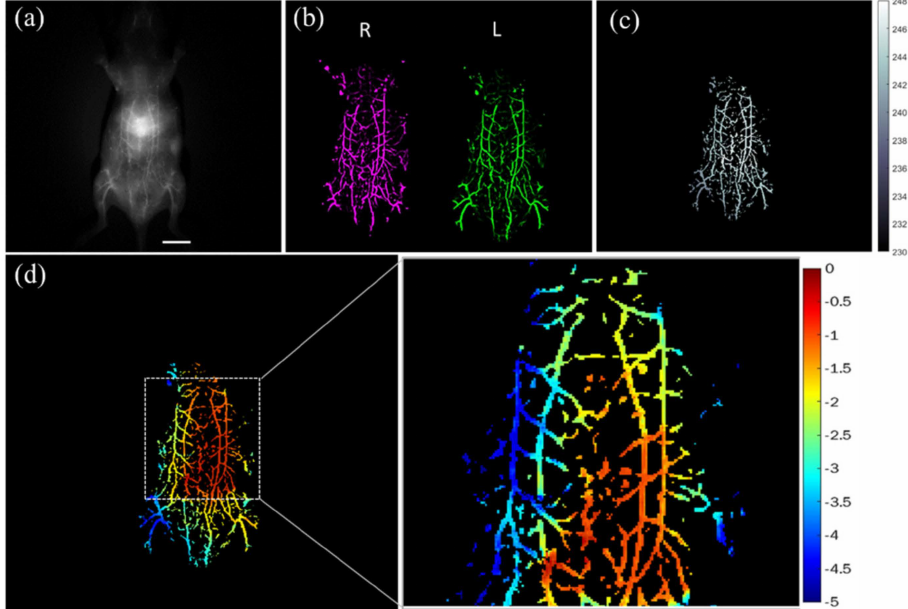
Figure 6. Results of in vivo 3D blood vessel study: ( a ) 2D NIR-II image (scale bar, 10 mm), ( b ) left and right vessel enhanced images, ( c ) disparity map of the mice’s blood vessels, and ( d ) depth map of the mice’s blood vessels in the abdominal region.